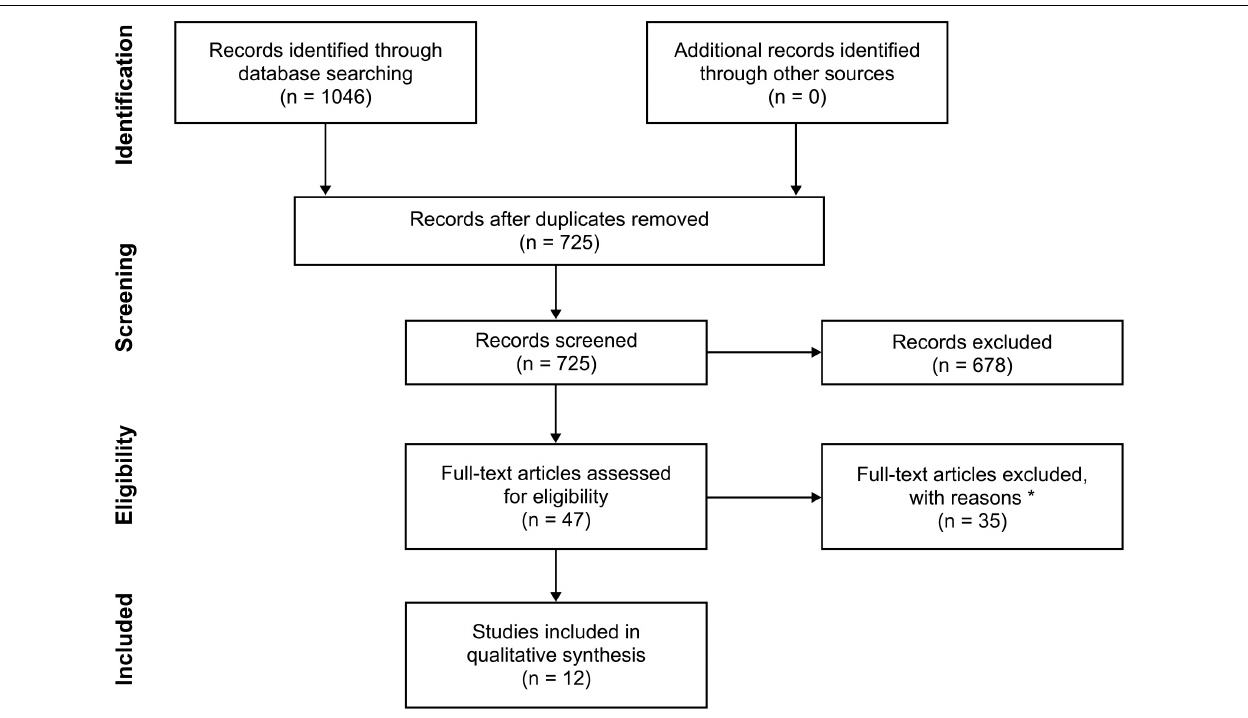
FIGURE 1 | PRISMA diagram of study selection process. * No experimental group of habitual gamers ( n = 19); no valid parameters of sleep or insomnia ( n = 10); non-adult cohort ( n = 4); unable to retrieve full text for appraisal ( n = 1); article was retracted by the publishing journal ( n = 1).